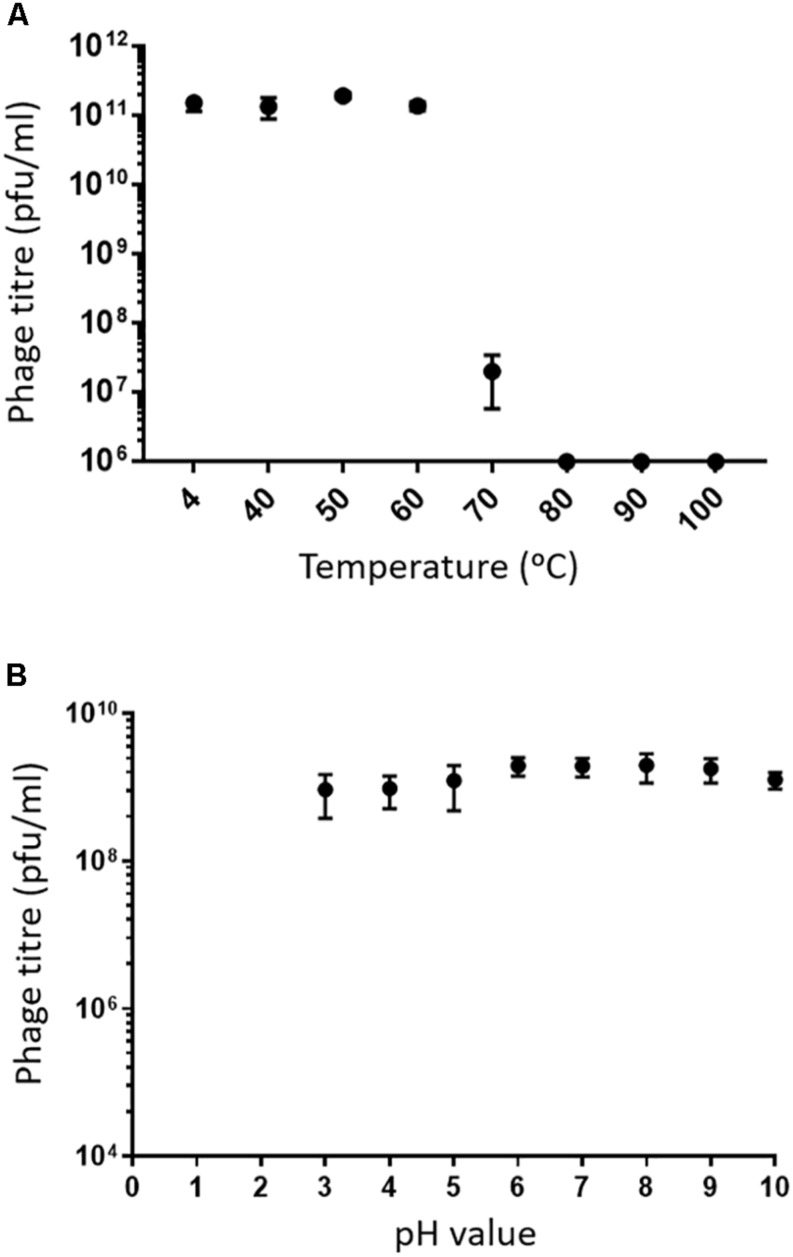
(A) Thermal stability of MIJ3: the phage was incubated in LB medium at different temperatures for 60 min. The phages survived at temperatures of 40, 50, and 60°C. At 70°C, phage concentration showed a 4-log drop. MIJ3 was not able to survive at 80, 90, and 100°C. Error bars represent SEM for three replicates. (B) pH stability of MIJ3. The phage is highly stable at pH values from 3 to 10; however, no survival was observed when phages at a pH of 2 and 1.